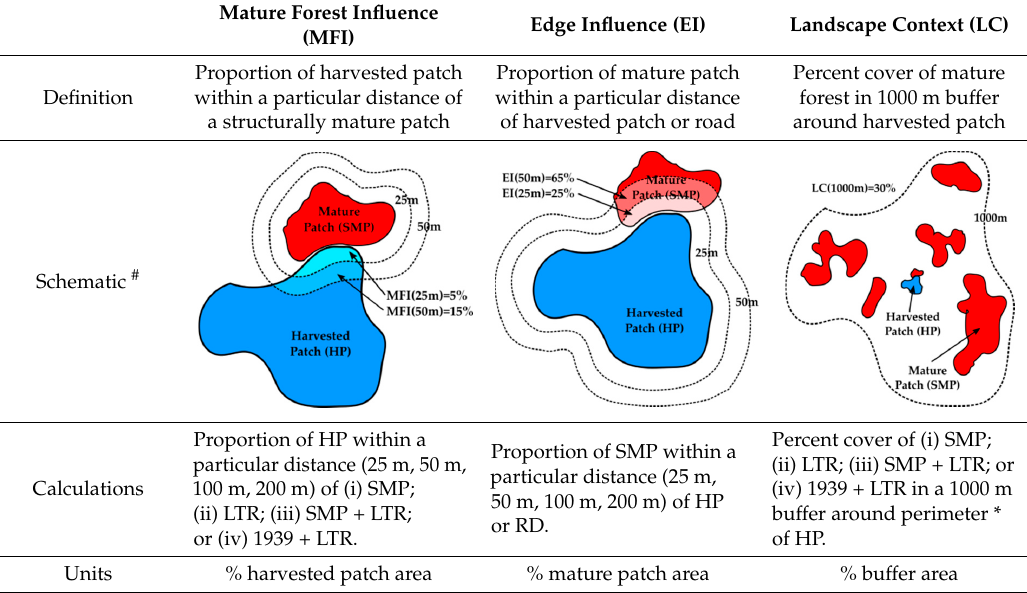
Table 2. Geospatial metrics to quantify (a) the influence of structurally mature forest on historically harvested patches (Landscape Context and Mature Forest Influence) and (b) the influence of harvested patches and roads on structurally mature forest (Edge Influence). Mature Forest Influence and Landscape Context metrics were also calculated for all forest types in long-term retention, mature forest in long-term retention and 1939 regrowth in long-term retention (Victoria only).